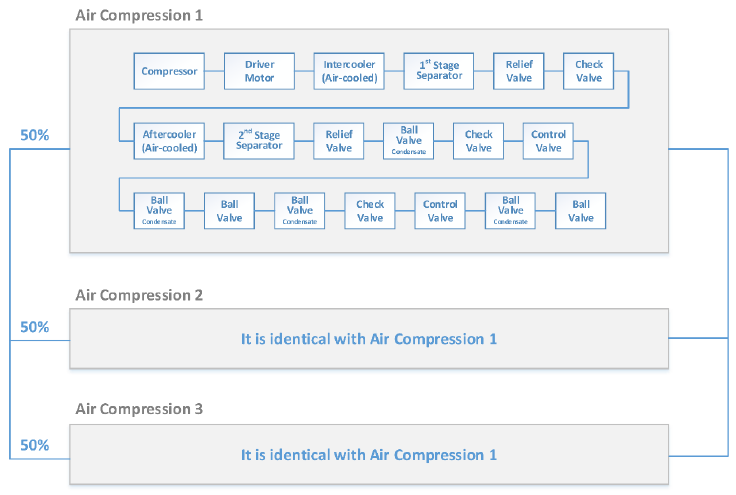
Figure 8. Reliability block diagram at Stage II (preliminary P&ID stage)—Air compression part.